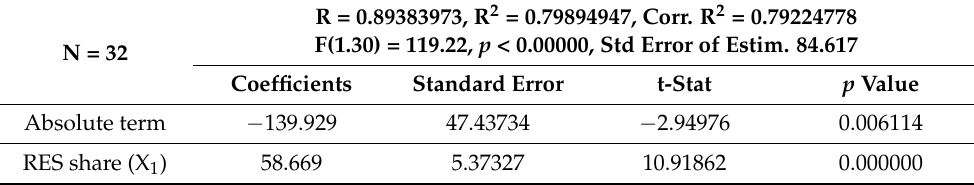
Table 6. The results of modeling the Gross Domestic Product in Poland in 1991–2022 using a linear econometric model of one variable.